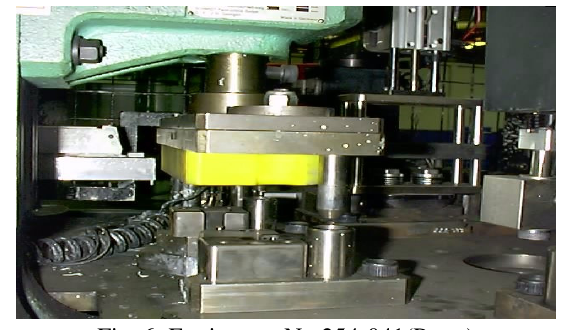
Fig. 6: Equipment No.254-041(Press)